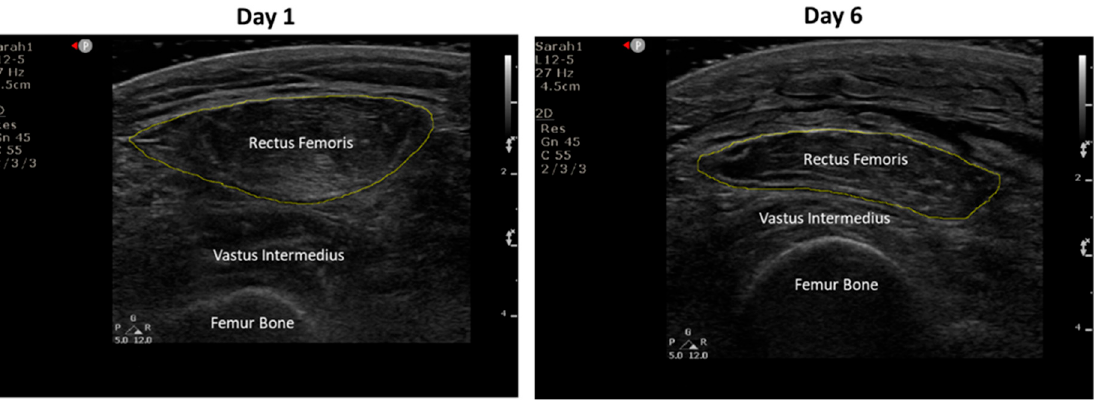
Figure 2. Representative ultrasound images of Rectus femoris cross-sectional area (RFCSA) on days 1 and 6 of study